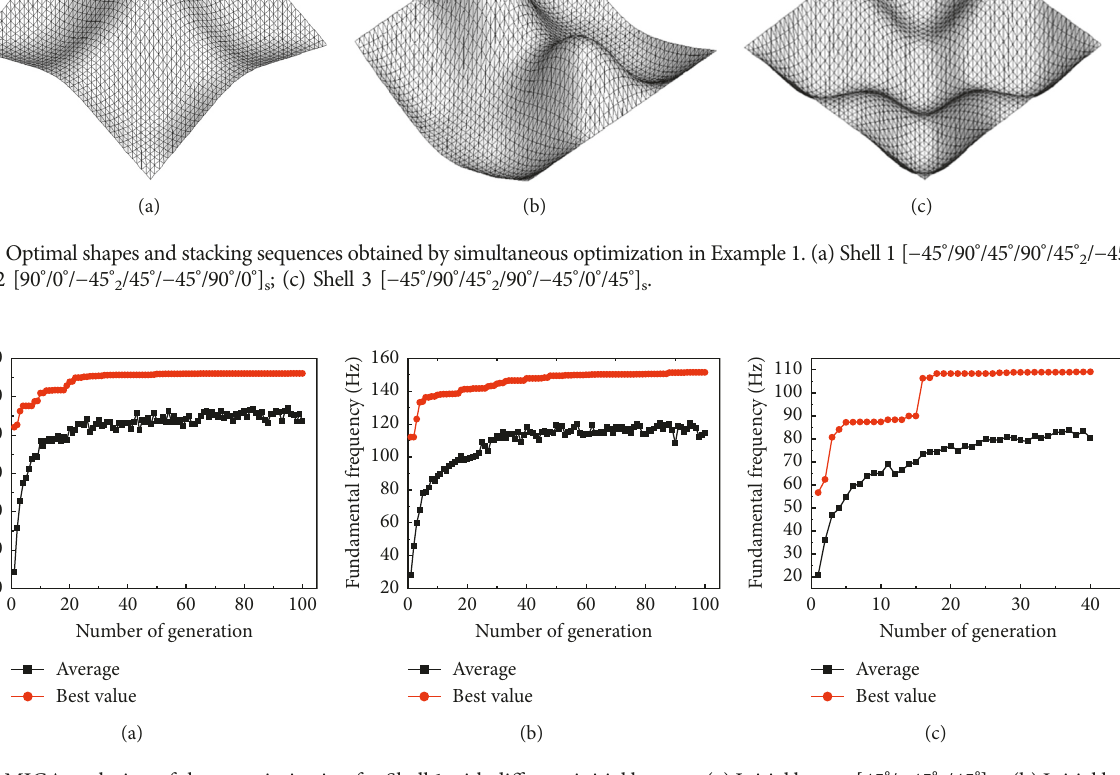
° ] 2 /45 2s . (b) Initial lay-up